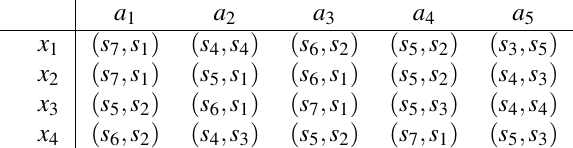
Table 2. Decision matrix R 2